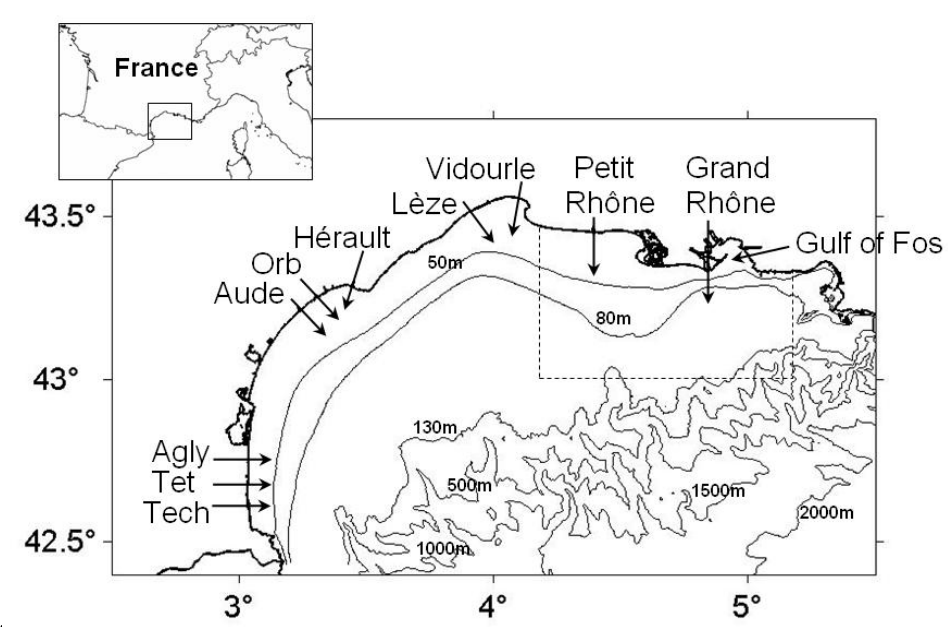
Figure 2. Rivers along the coasts of the GoL and bathymetry. The rectangle in dotted line is the Rhône region considered in Figure